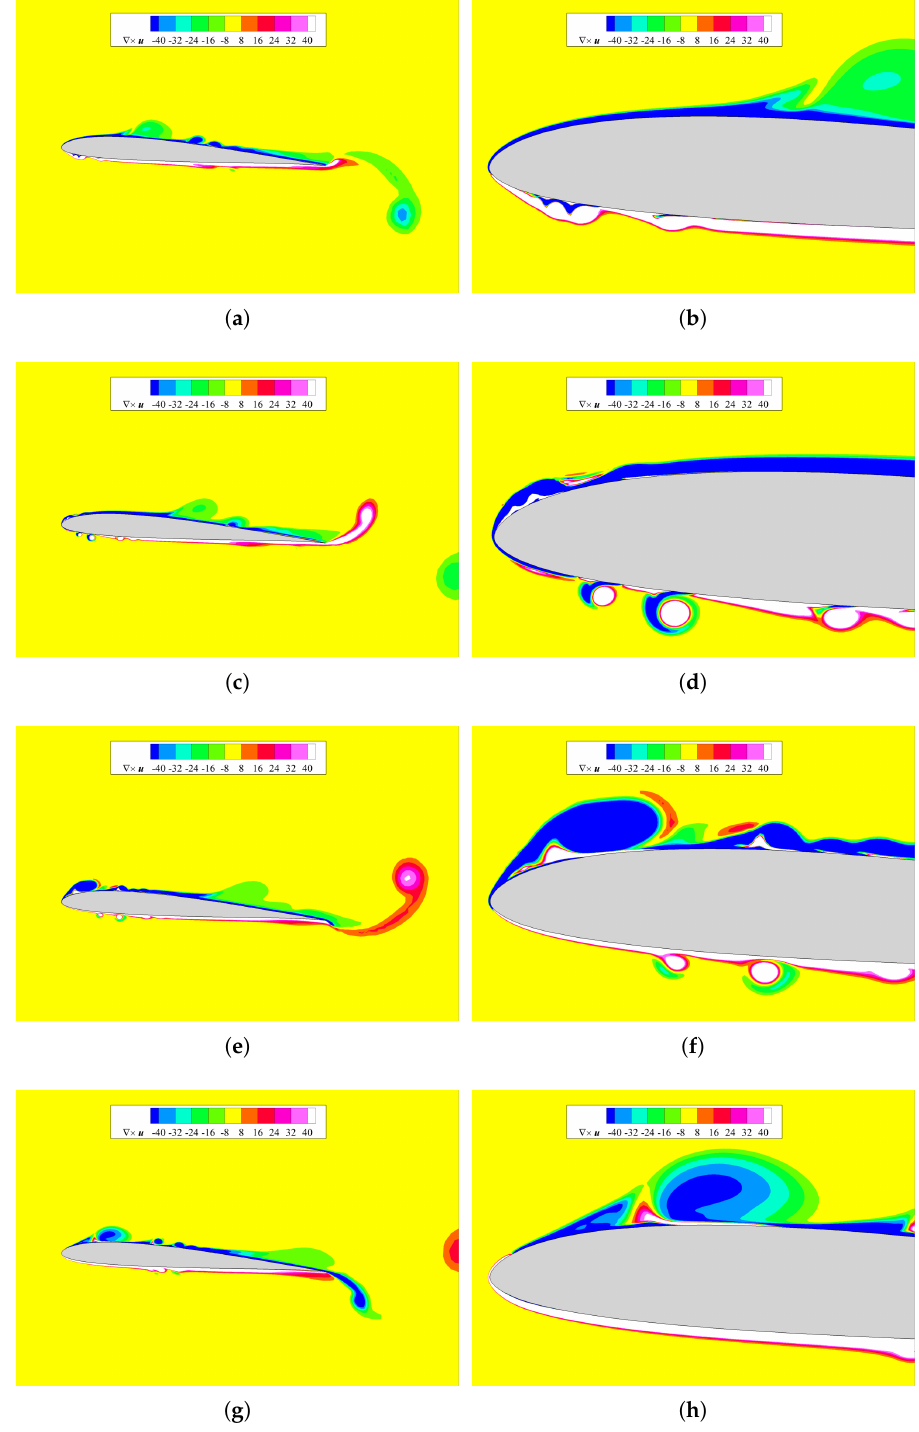
Figure 9. SA − BCM model. Contour of instantaneous spanwise vorticity. From top to bottom, the vertical positions are presented in the sequence: ( a , b ) Φ = 0; ( c , d ) Φ = 0.25; ( e , f ) Φ = 0.5; ( g , h ) Φ = 0.75. The right column reports the details of the instability developing at leading